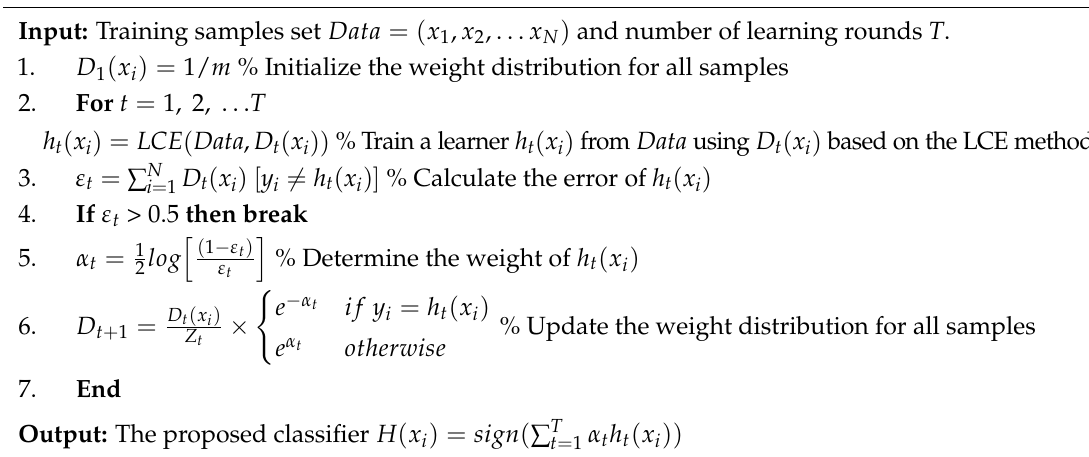
Algorithm 1. The pseudo code of the constructed